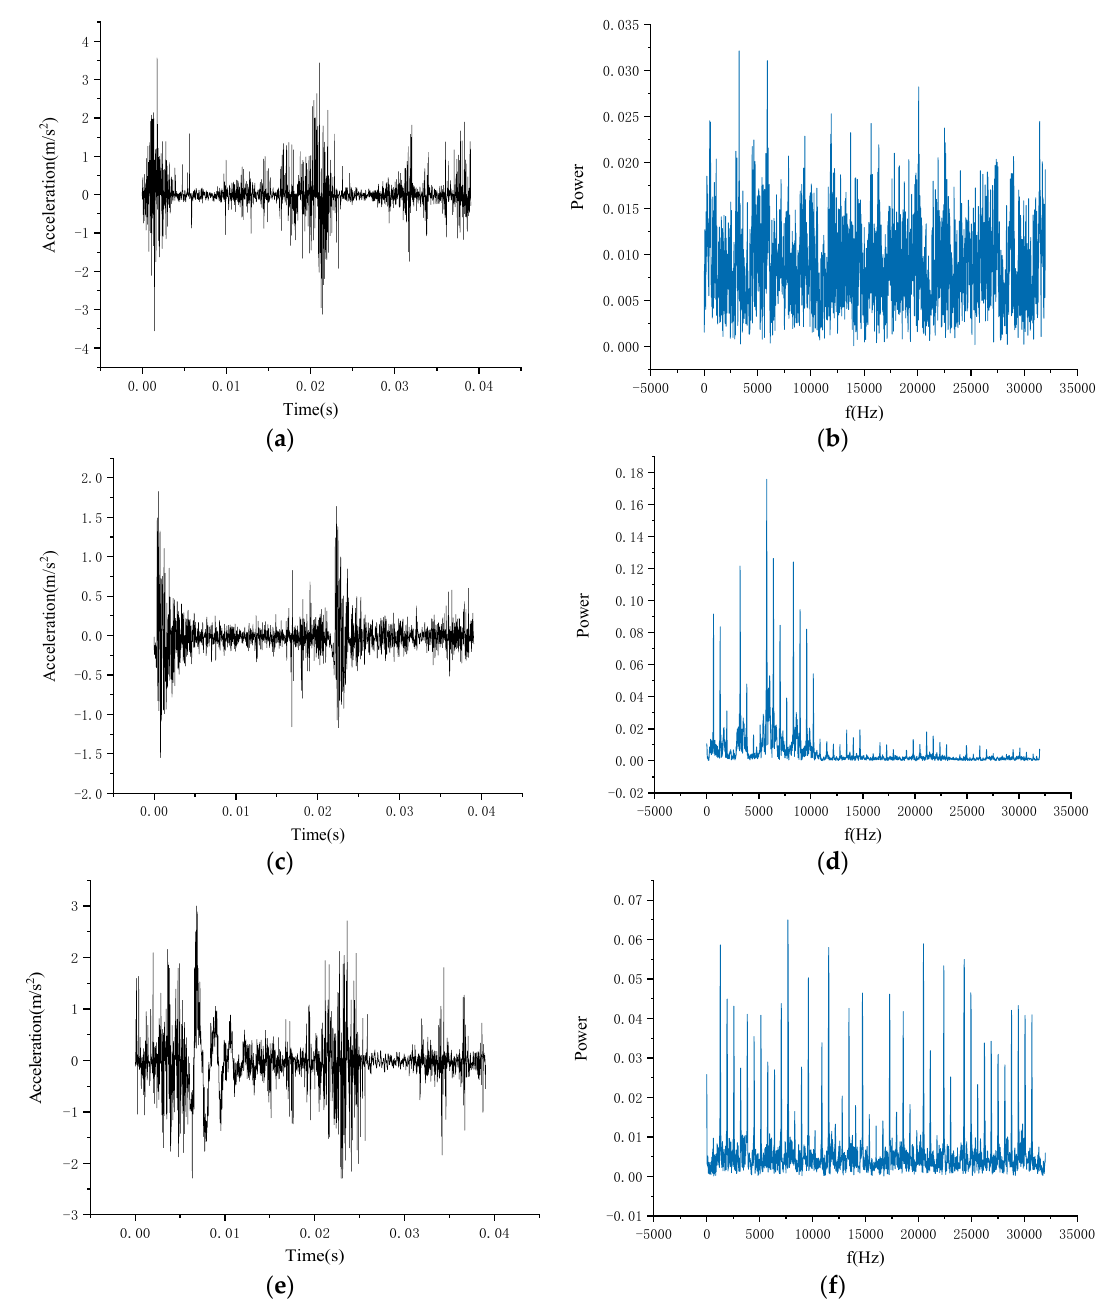
Figure 6. Visualization of signal in time domain and frequency domain. ( a , c , e ) are time domain images of signal, ( b , d , f ) are the frequency domain images of signal.